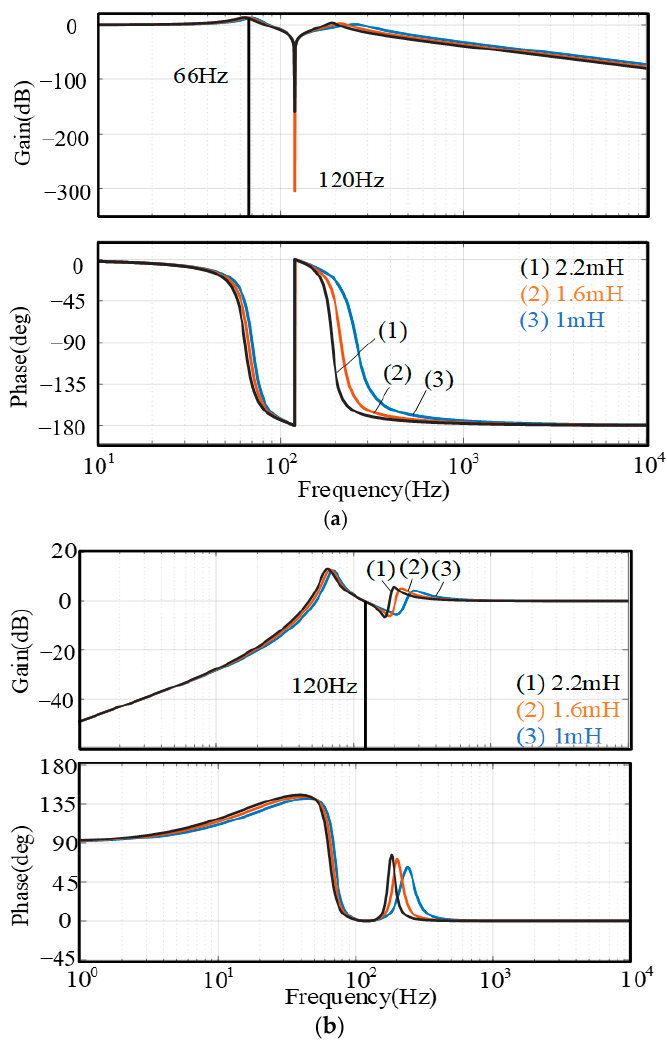
Figure 6. Bode plot of the transfer function proposed in this paper. ( a ) G 3 (s). ( b ) G 4 (s).